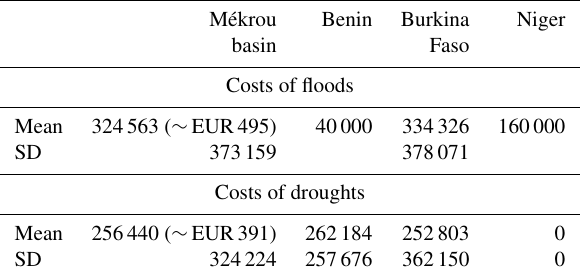
Table 9. Estimated costs of the recent flood and droughts (in